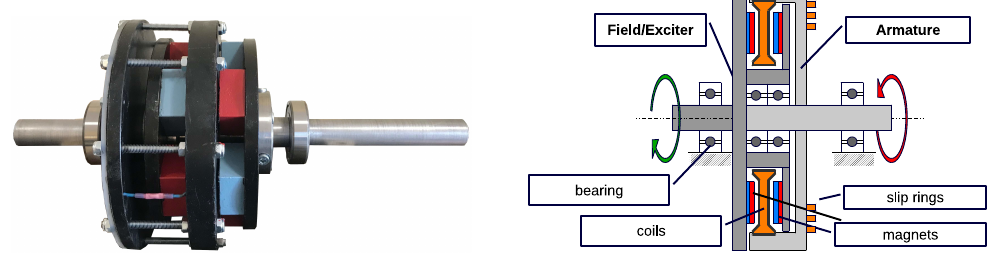
Figure 9. The internal structure of the prototype axial flux generator ( left ), a transversal cross-section ( right